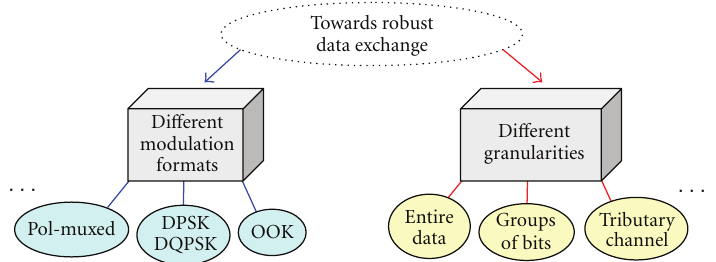
Figure 1: Schematic illustration of robust data exchange